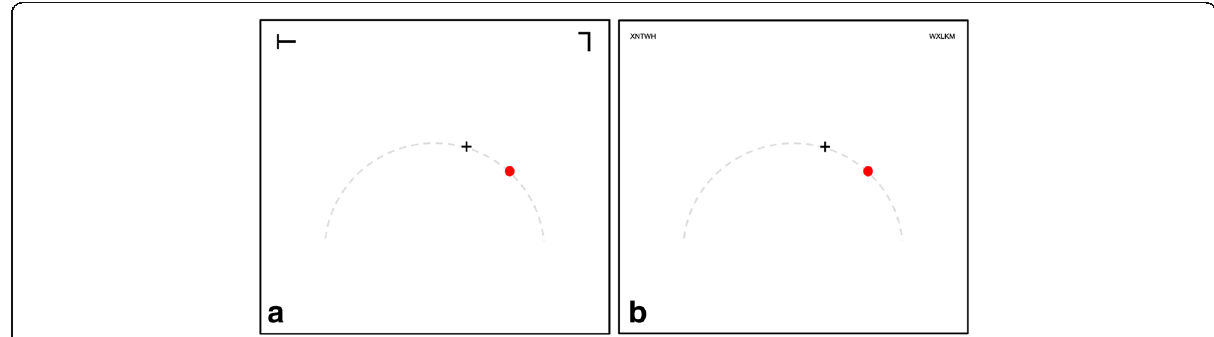
Fig. 1 a A single-target dual-task trial from either Experiment 1b or the dual-task condition of Experiment 2. b A single-target dual-task trial from Experiment 3. The participant pressed a button when they detected the target (in the top left of these figures). The tracking task involved manually maneuvering the black cursor (+) with the moving red circle. The black cursor and the red circle moved along an invisible arc (presented here as a dashed line). Stimuli for the single- and dual-task experiments/conditions were similar, except the black cursor was not visible in the single-task